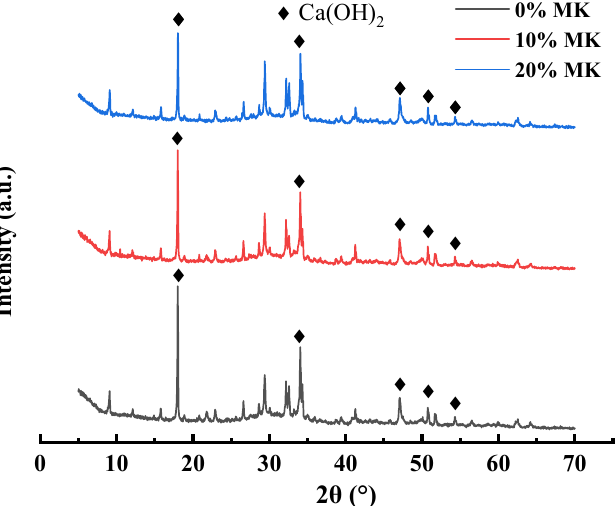
Figure 6. The microstructure of concrete at 0.45 w / c ratio at 28 days.